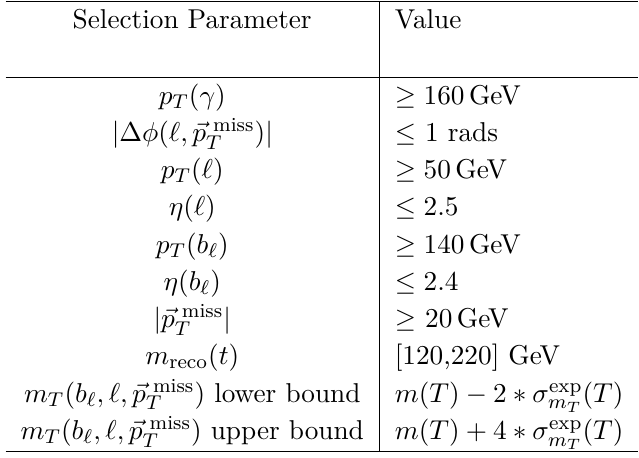
Table 3. Selection cut values for all mass points in this